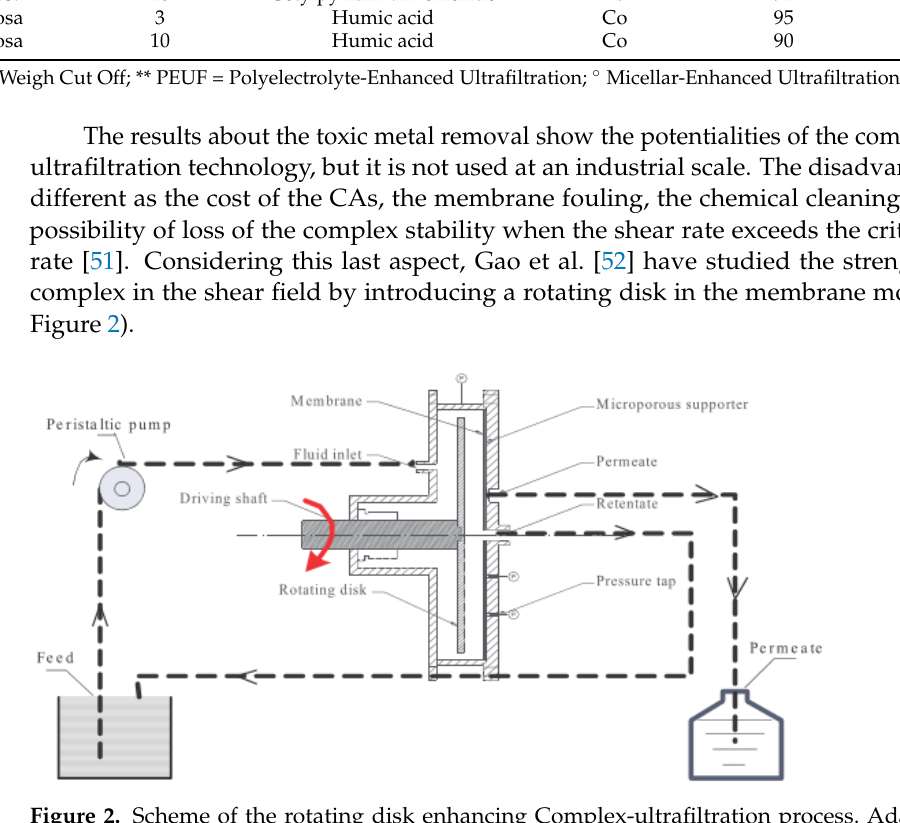
Figure 2. Scheme of the rotating disk enhancing Complex-ultrafiltration process. Adapted with permission from ref. [52]. Copyright 2021 Elsevier.